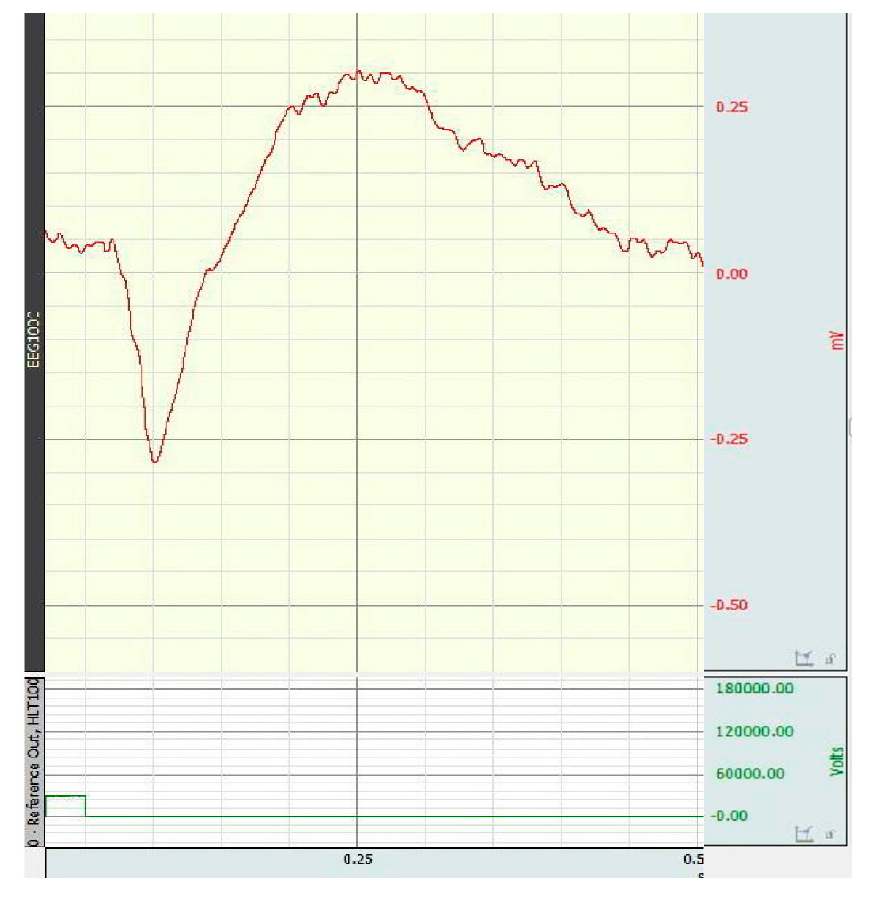
Figure 1. Electroretinogram of rat in control group.